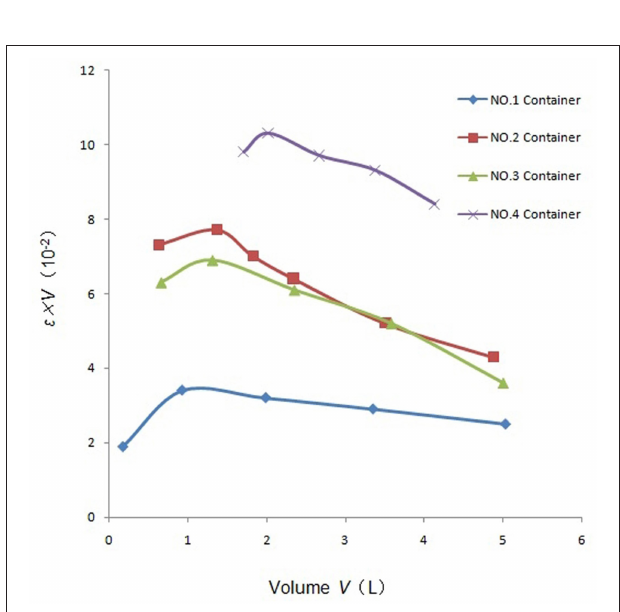
FIGURE 6 | ε V vs. container volume (simulation •